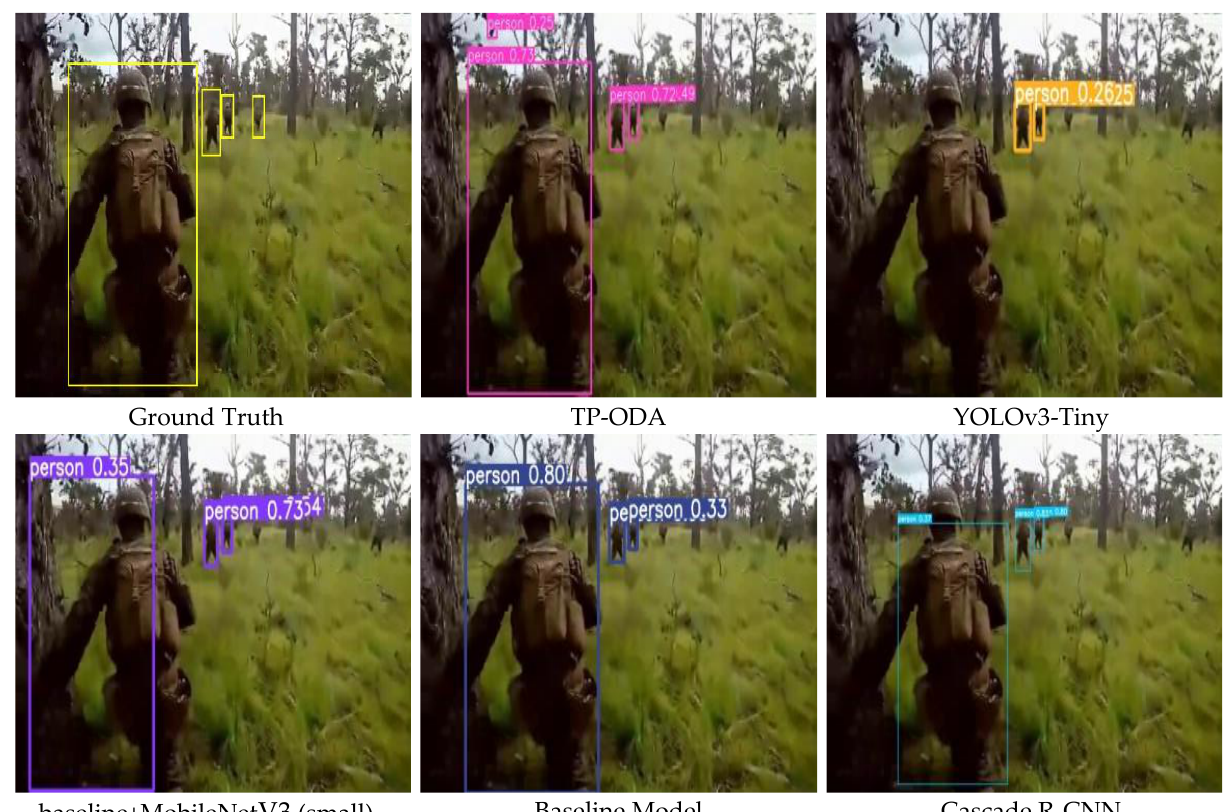
Figure 8. Jungle background visualization detection results. Table 7. The TP-ODA model was compared to the other